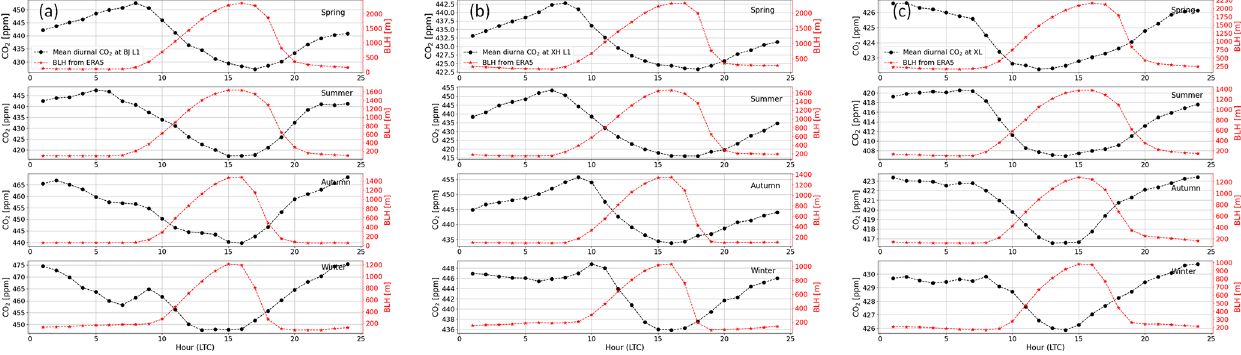
Figure 10. (a–c) Mean diurnal cycles of BLH from ERA5 and mean diurnal CO 2 variations at BJ L1 (a) , XH L1 (b) , and XL (c) in each season between October 2018 and September